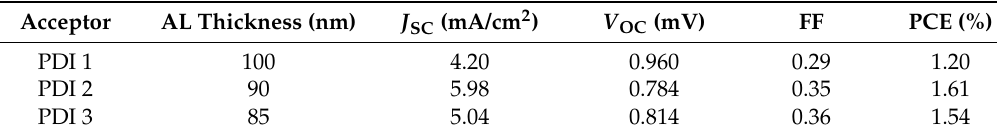
Figure 3. ( a ) J – V characteristics of the best performing PTB7:PDI devices recorded at 1 SUN A.M 1.5 illumination; ( b ) external quantum efficiency (EQE) spectrum of devices made from PTB7:PDI active layers. Table 1. Organic solar cell (OSC) device